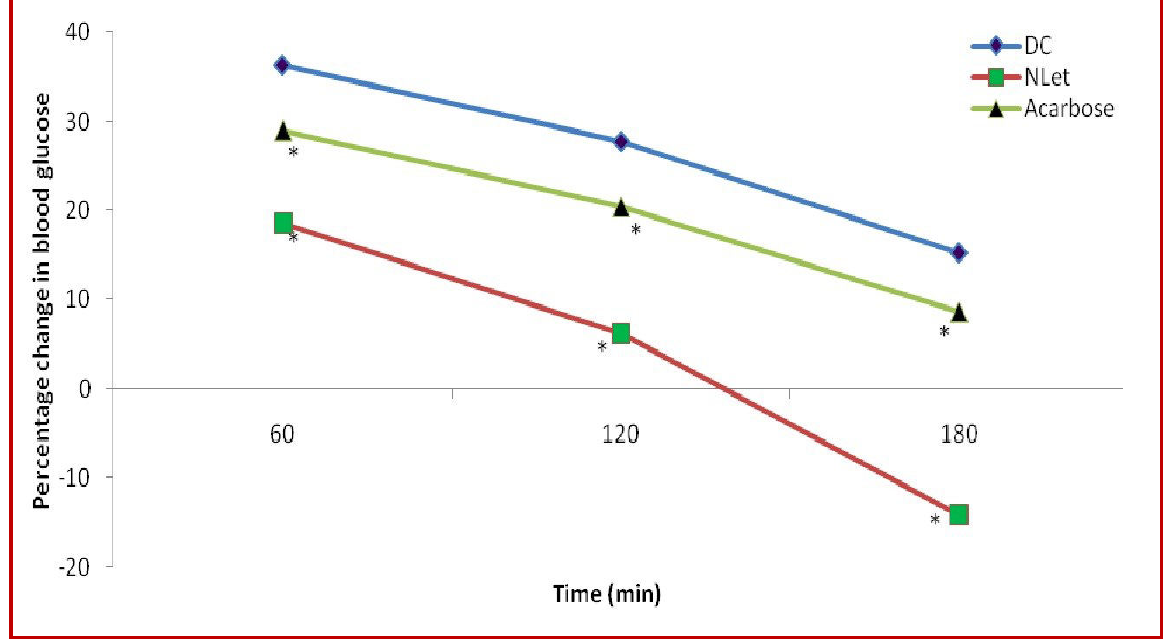
Figure 4: Effect of N. laevis extract on blood glucose level in diabetic rats after oral sucrose load Values are expressed as the mean ± SEM (n = 6). *p<0.05 compared to diabetic control. NLet = ethanolic extract of N. laevis ; DC = diabetic